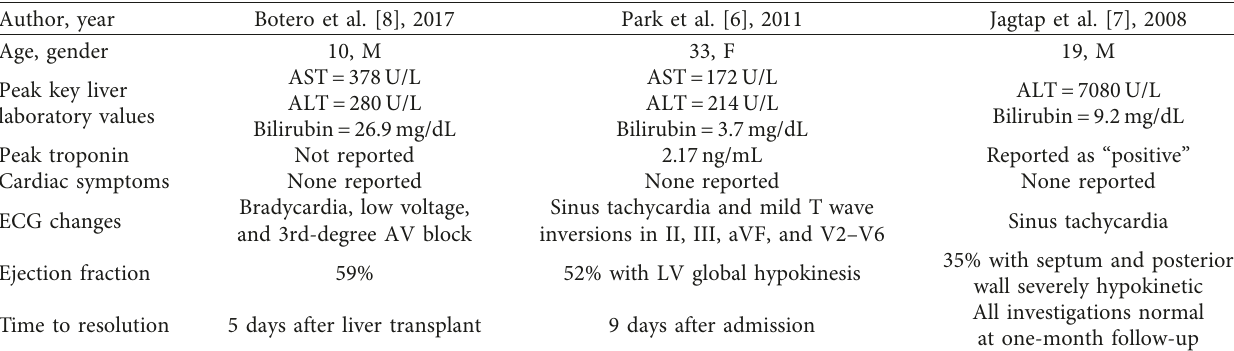
Figure 8: Trend of liver function tests and troponin obtained during hospital course. Day 1 is day of admission. Day 17 is outpatient follow- up. Table 4: Other reported cases of myocarditis in hepatitis